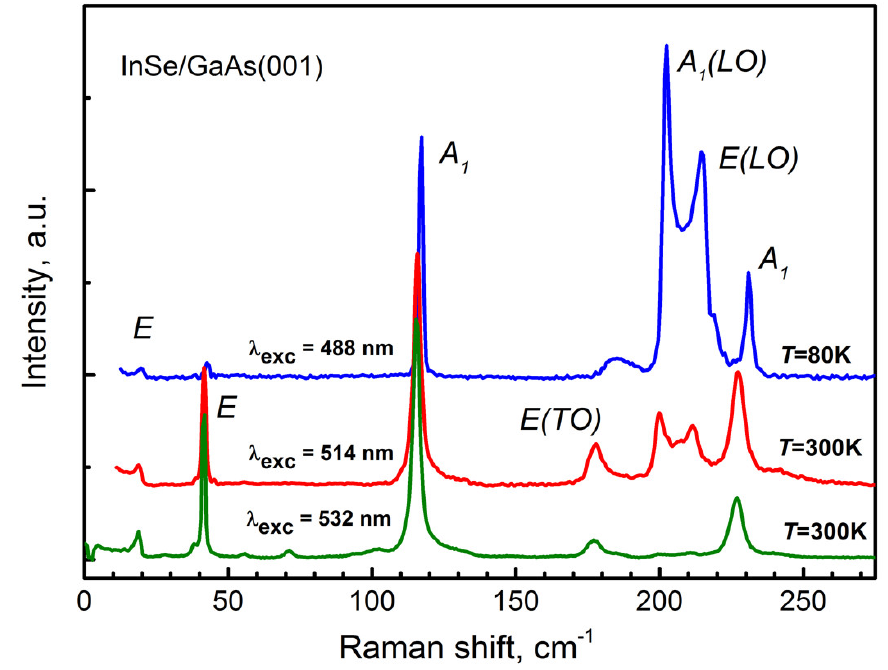
Figure 11. The near-resonance Raman spectra of the InSe/GaAs(001) layer (sample # IS1 ) measured at 300 K (λ exc = 514.5 nm, red curve) and at 80 K (λ exc = 488 nm, blue curve) along with the off-resonance Raman spectrum of the same layer measured at 300 K (λ exc = 532 nm, green curve). The spectra are normalized to the intensity of the A 1 (115 cm −1 ) phonon line.